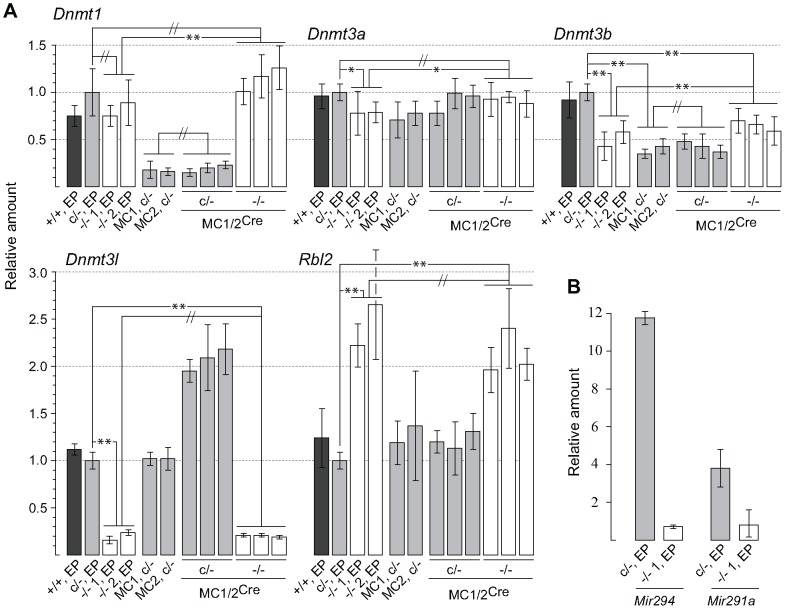
qPCR assays.(A) Values obtained for the parental Dicer1
c/− line were used to calibrate all other values, and are set at 1.0. The y axis is a linear scale. Bars are mean ± s.d. Probabilities obtained from Student's t-test, 2-tail, type 2: P<0.05 (*), P<0.01 (**), not significantly different (//). Bar 1; Dicer1
+/+ cell line 2A at early passage (EP). Bar 2; parental Dicer1
c/− EP line. Bars 3 and 4; Two independent Dicer1
−/− EP lines derived from Cre transfection of the parental Dicer1
c/− EP line. Bars 5 and 6; Two independent sublines (MC1 and MC2) derived from concatemeric targeting at Hprt with the Dnmt1 shRNA. Bars 7–9 and 10–12; three sublines derived from exposure of MC1 (two sublines) and MC2 (one subline) to Cre (MC1/2) that did not excise (c/−) and did excise (−/−) the floxed Dicer1 sequence, respectively. (B) Measurements were of the parental Dicer1
c/− line and one Dicer1
−/− subline. The y axis is a linear scale. Values are normalized to those obtained for Rps7, which are set at 1.0. Other details are contained in the Materials and Methods section.